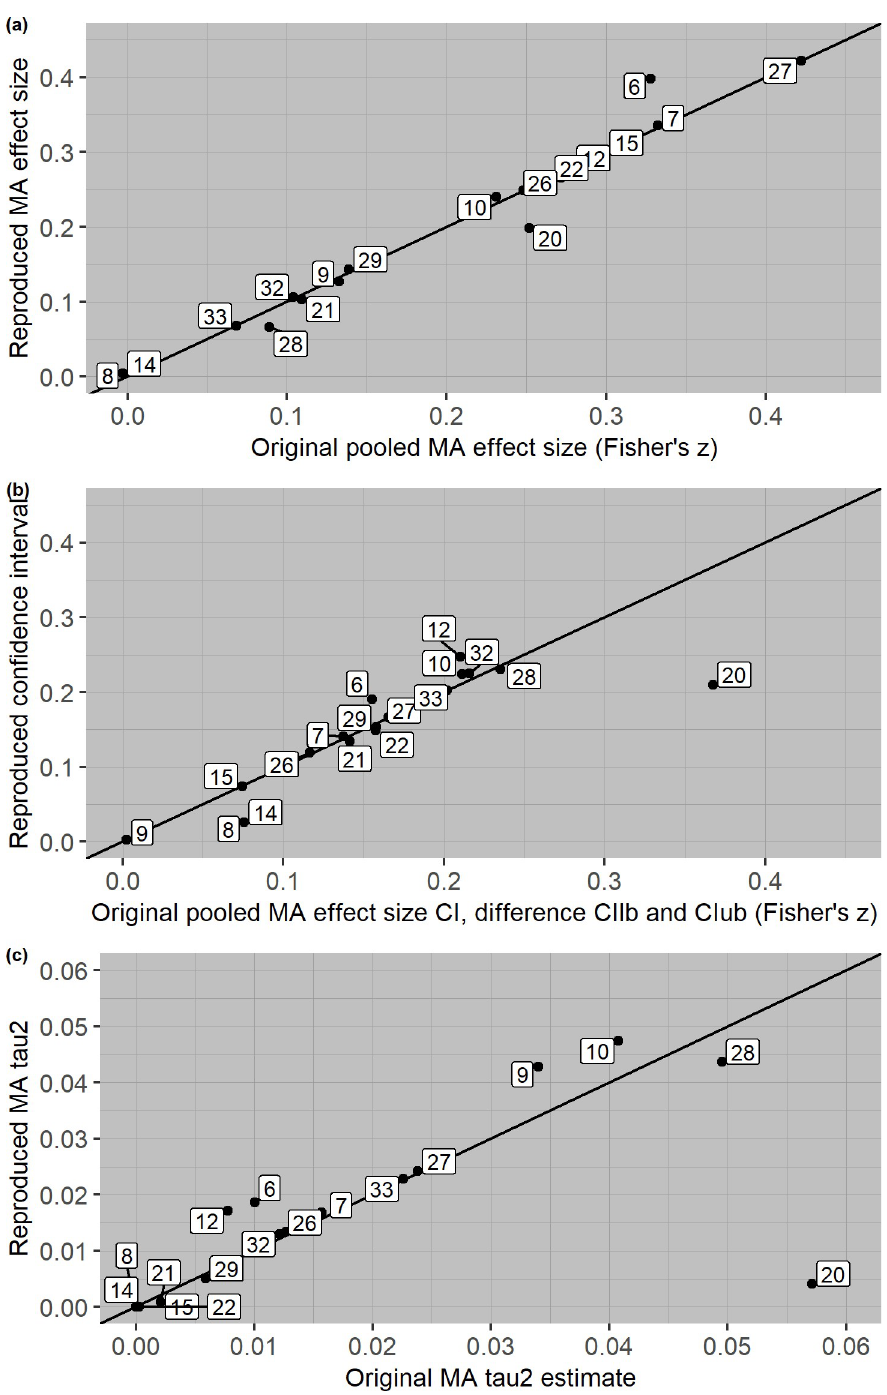
Fig 6. Scatterplot of reported and reproduced meta-analytic outcomes for meta-analyses using correlations, where all product-moment correlations r are transformed to Fisher’s z . That the scale of panel c is different from panel a and